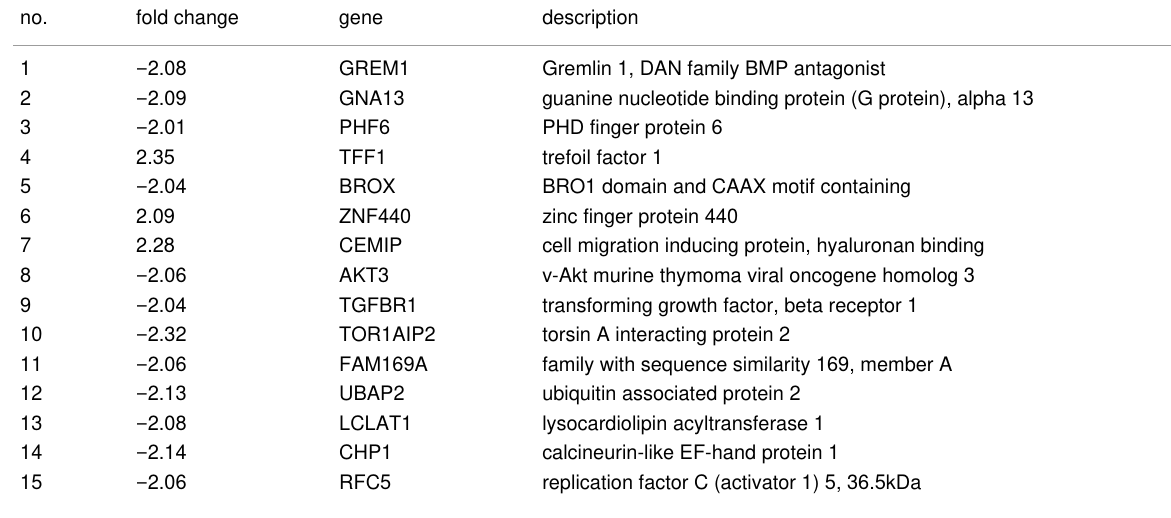
Table 2: Genes that were regulated by the